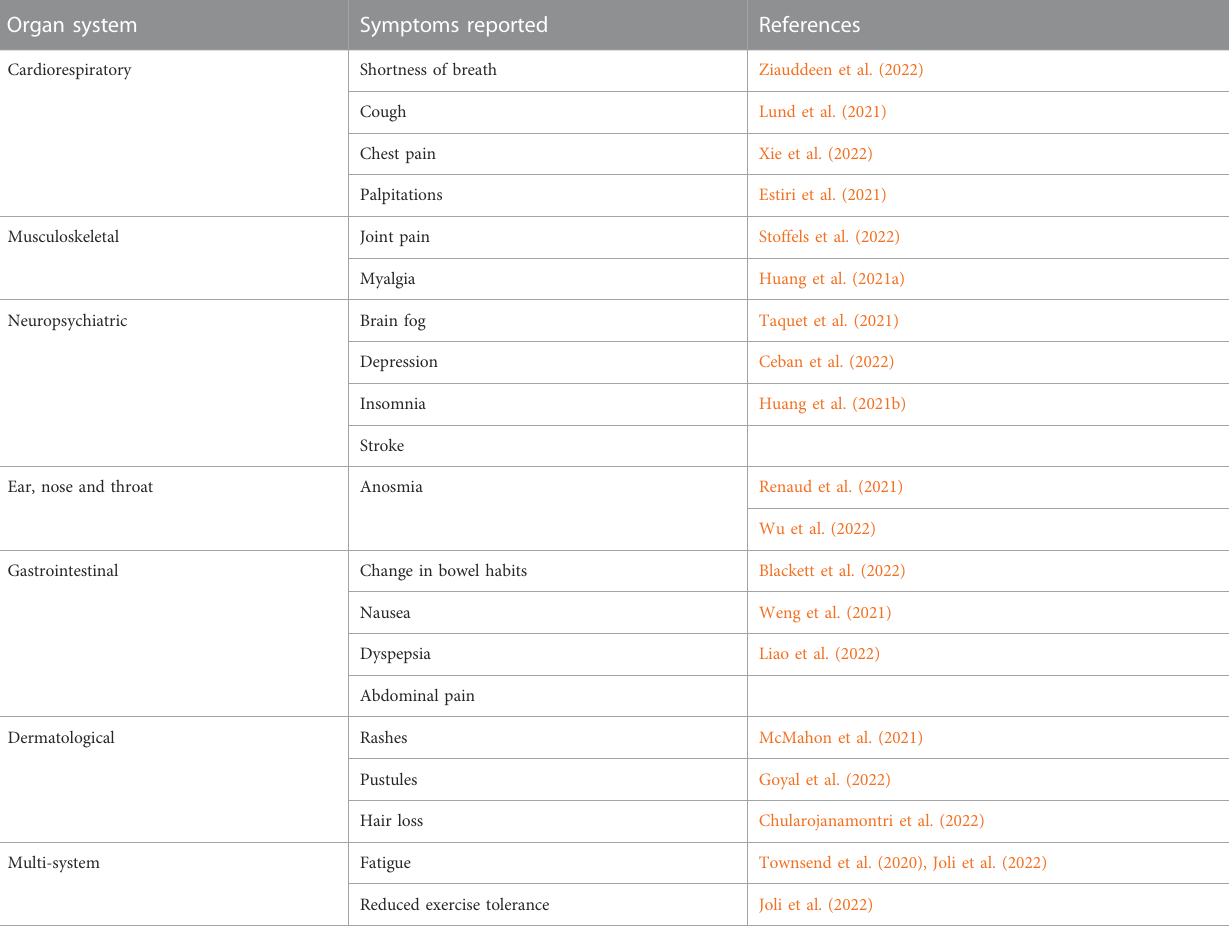
TABLE 2 Organ-speci fi c phenotypes. Organ